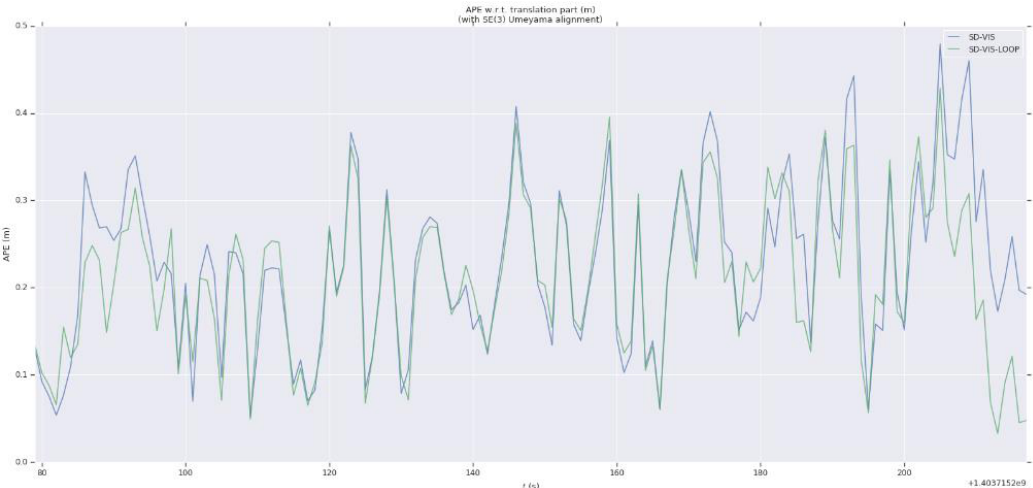
Figure 11. The change of translation absolute pose error with time in V1_01_easy. Blue and green represent SD-VIS and SD-VIS-LOOP respectively.